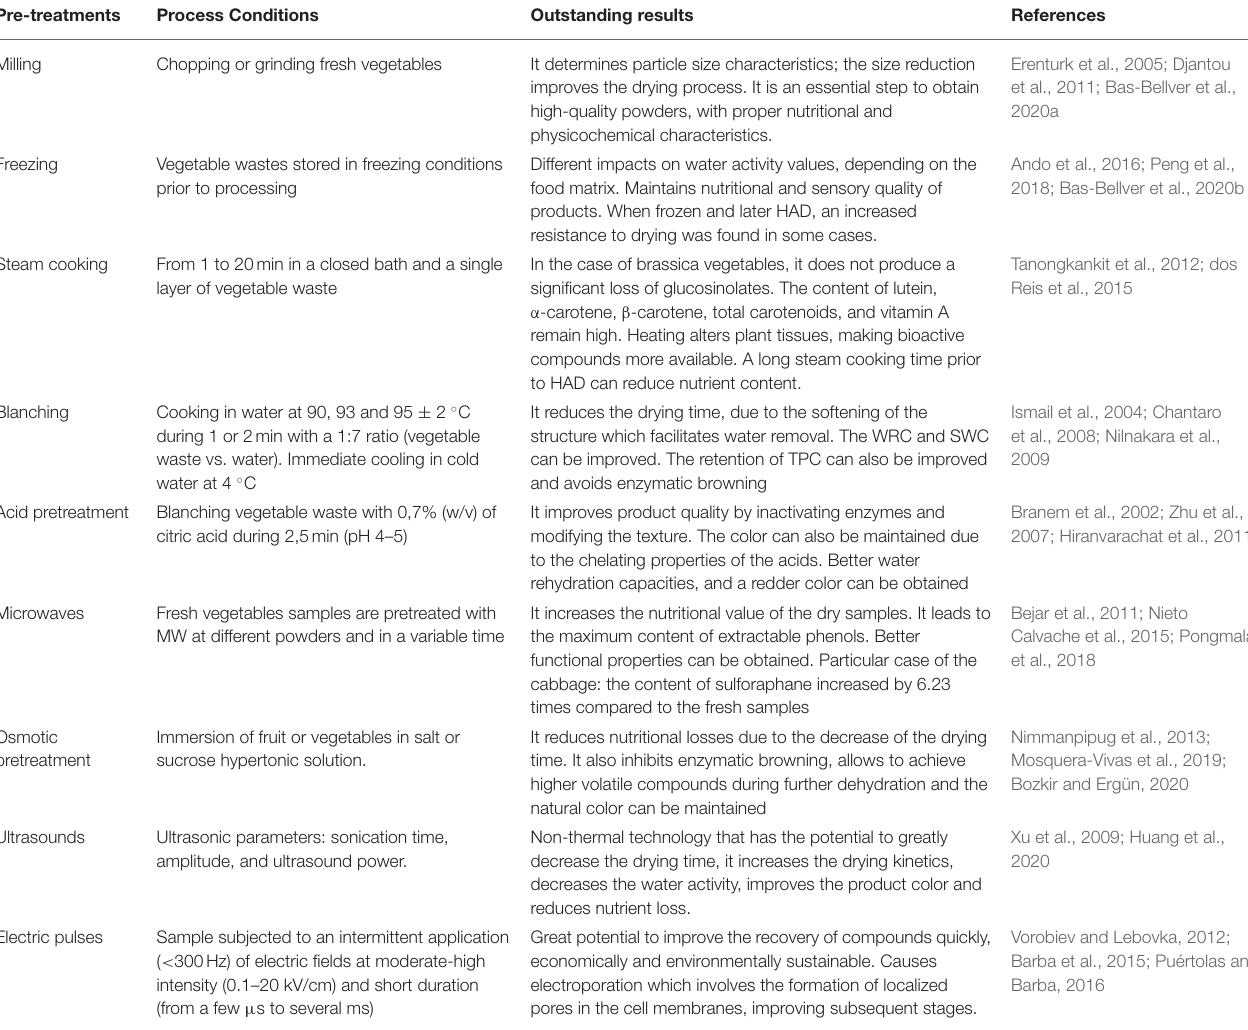
TABLE 2 | Pretreatments discussed in the literature and potential impact on fruit and vegetable tissue and its bioactive